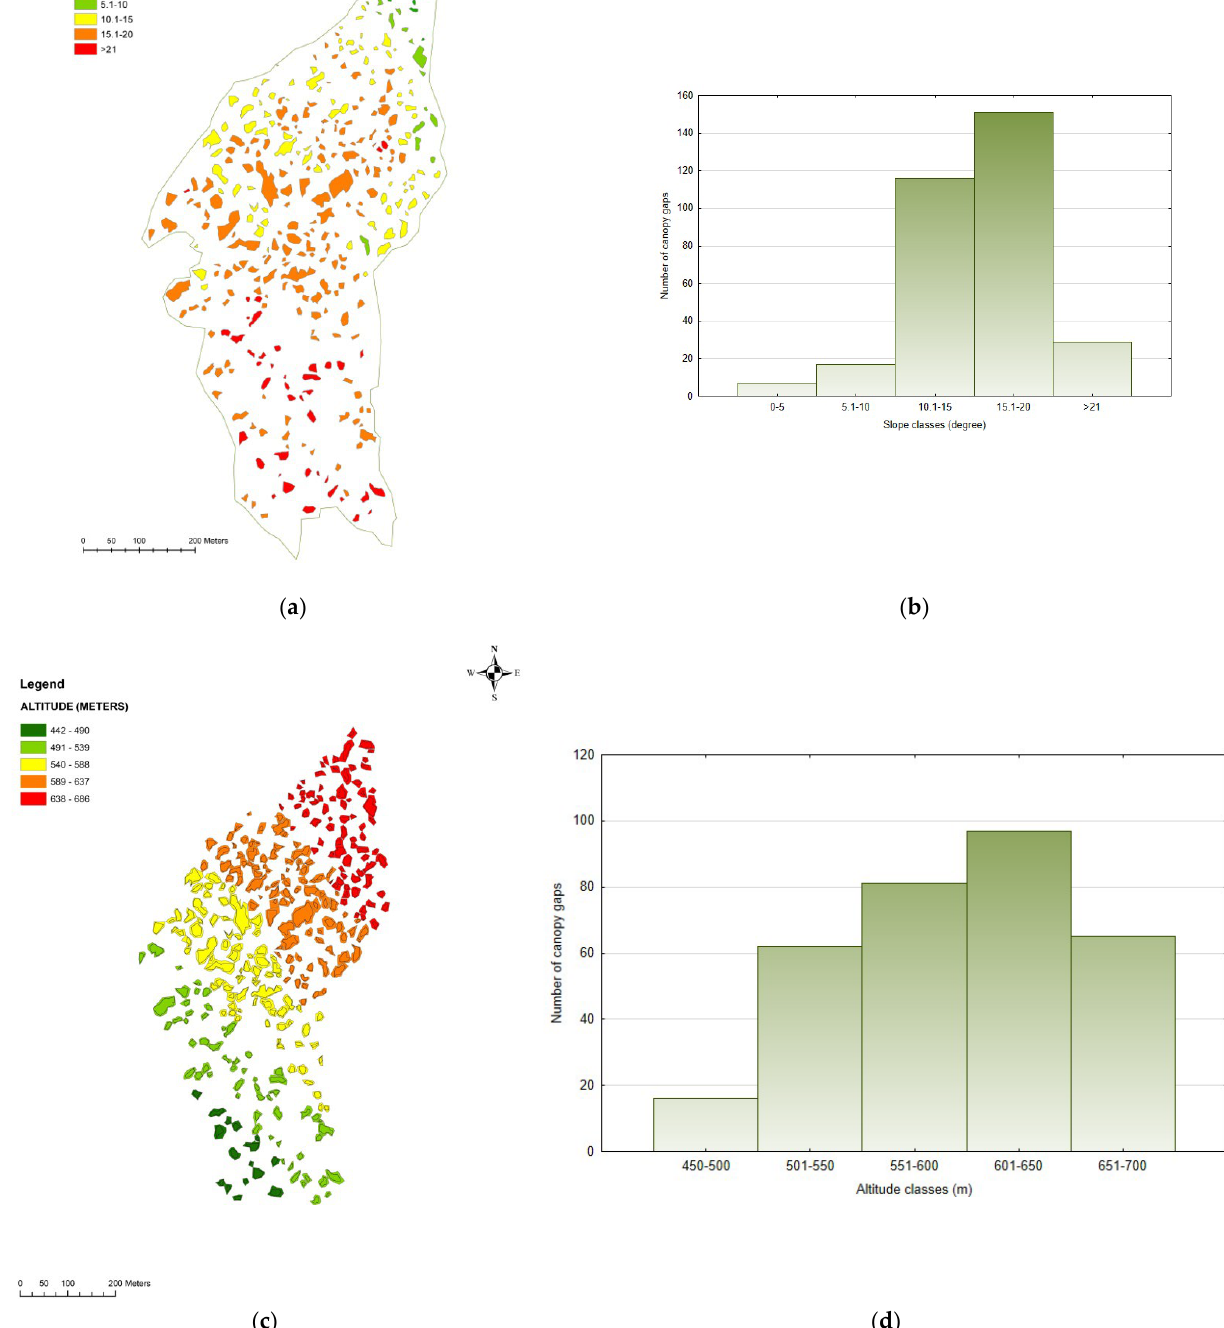
Figure 3. Canopy gap distribution on slope and altitude is shown as ( a ) the spatial distribution of gaps in slope classes, ( b ) the distribution of canopy gap numbers in slope classes, ( c ) the spatial distribution of gaps in altitude classes and ( d ) the distribution of canopy gap numbers in altitude classes.